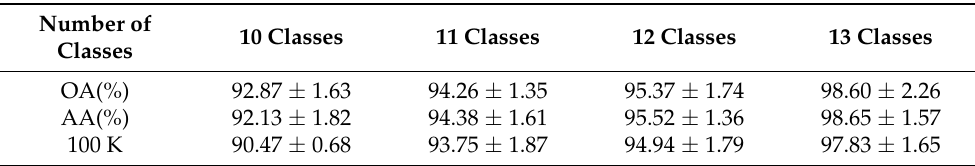
Table 10. Classification results on the KSC dataset with different numbers of classes with the DMLPFFN method.